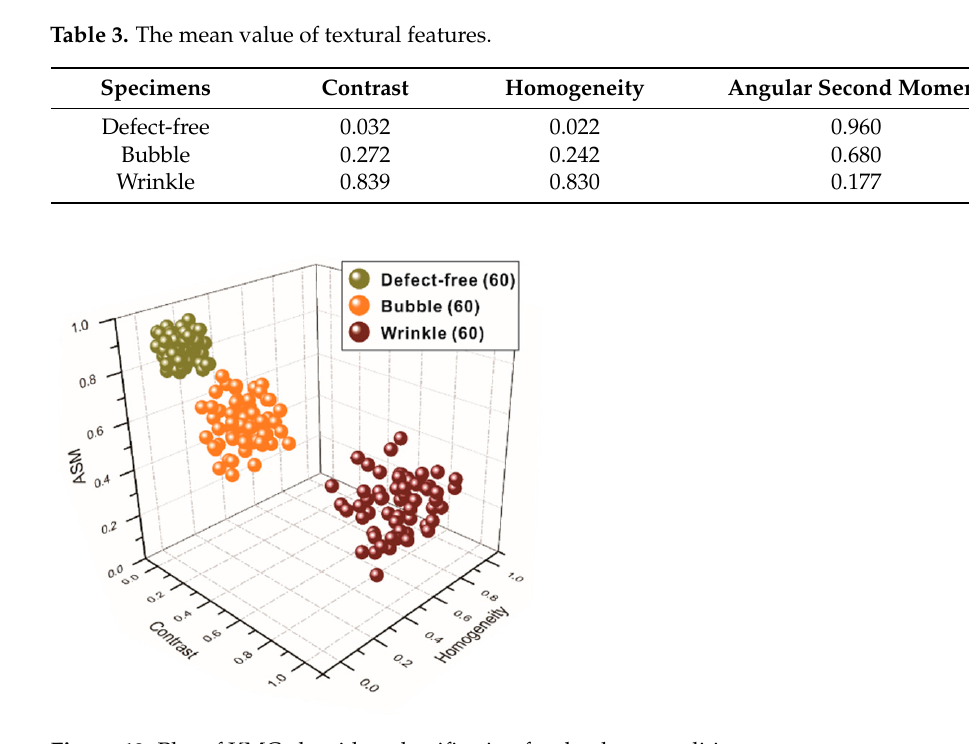
Figure 12. Plot of KMC algorithm classification for the three conditions.